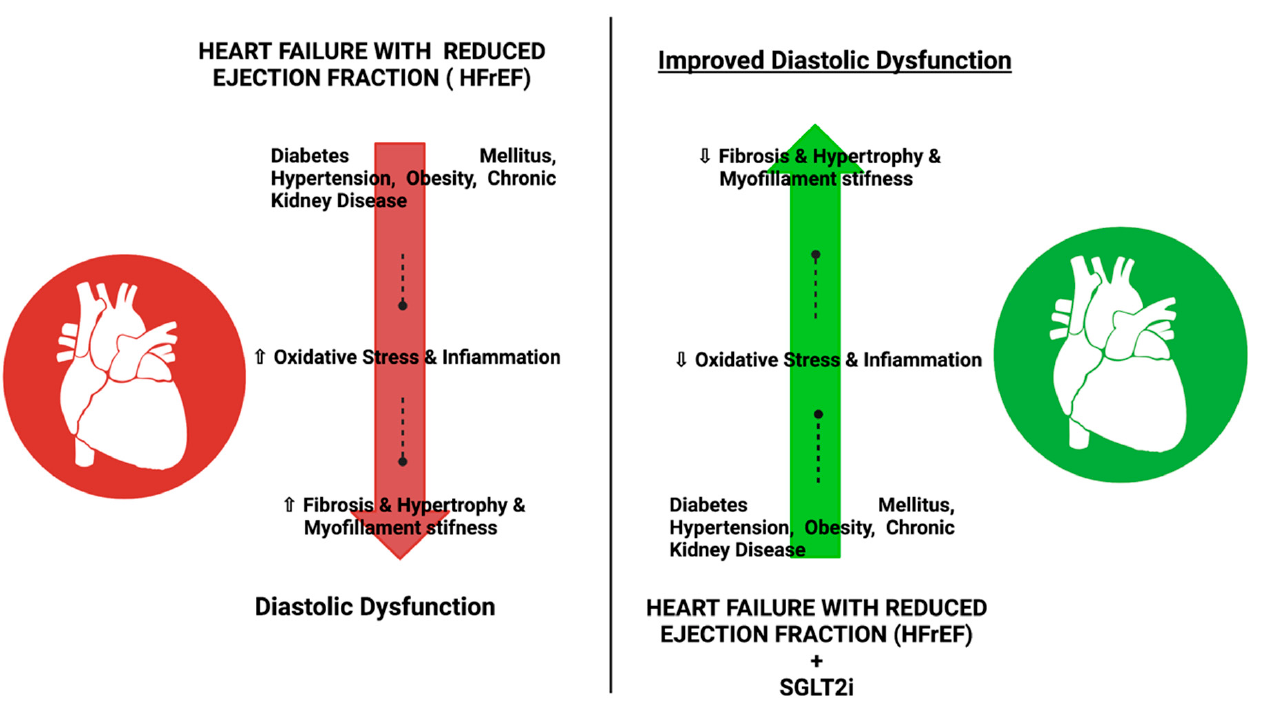
Figure 2. Effect of SGLT2i for the treatment of T2D in patients with HFpEF or HFrEF: The use of SGLT2i has shown improvement in diastolic dysfunction in patients with FHrEF or HF and reduced oxidative stress, infiammation, fibrosis, and myofilament stifness when compared with patients not using SGLT2i.